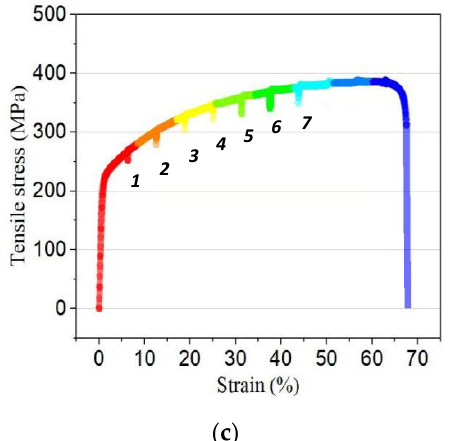
Figure 1. The in situ tensile experiment of 316 steel specimen. ( a ) The specimen size diagram; ( b ) The KW tensile stage; ( c ) The engineering stress–strain diagram. Table 1. Stress–strain data of the 316 stainless steel corresponds to each stretch point.